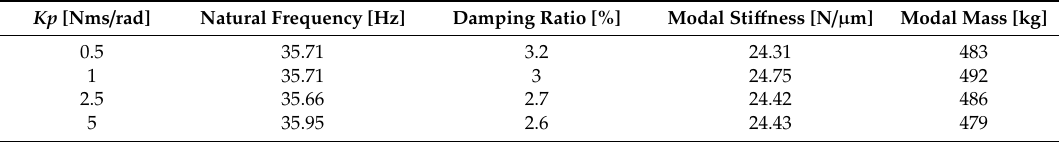
Table 2. Modal parameters of the machine tool for di ff erent velocity proportional gain values. Kp [Nms /